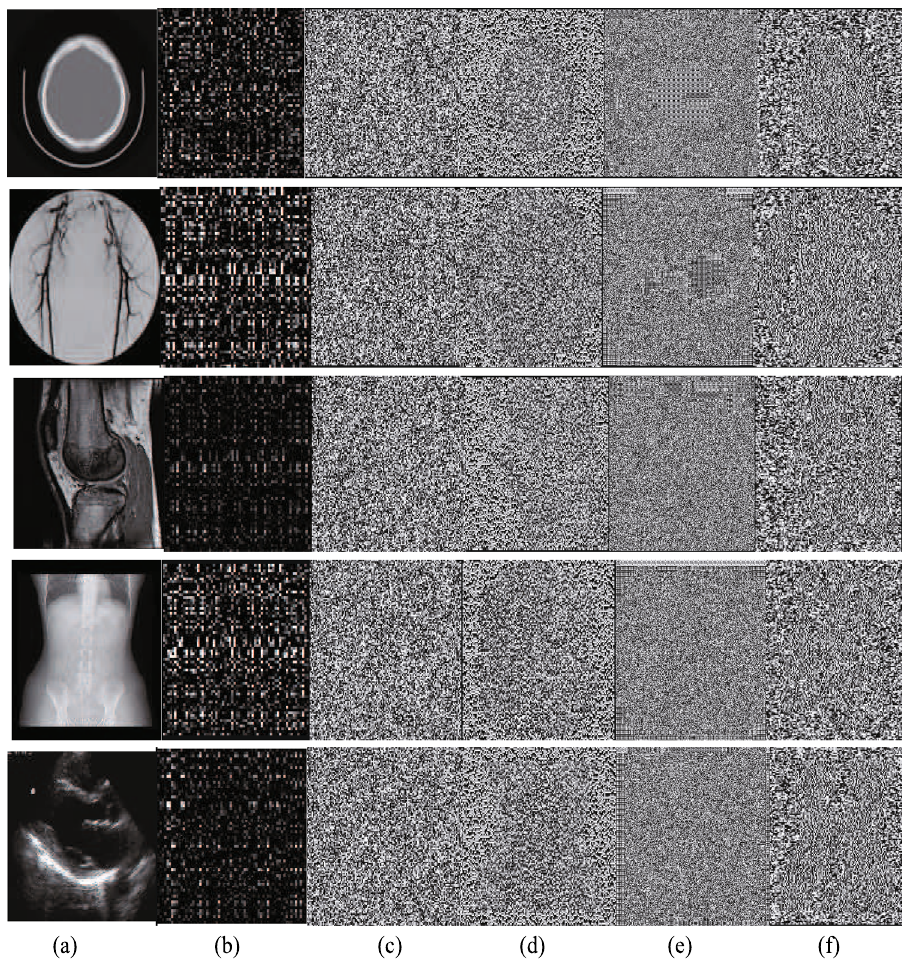
Fig. 7 Original medical images and encrypted images